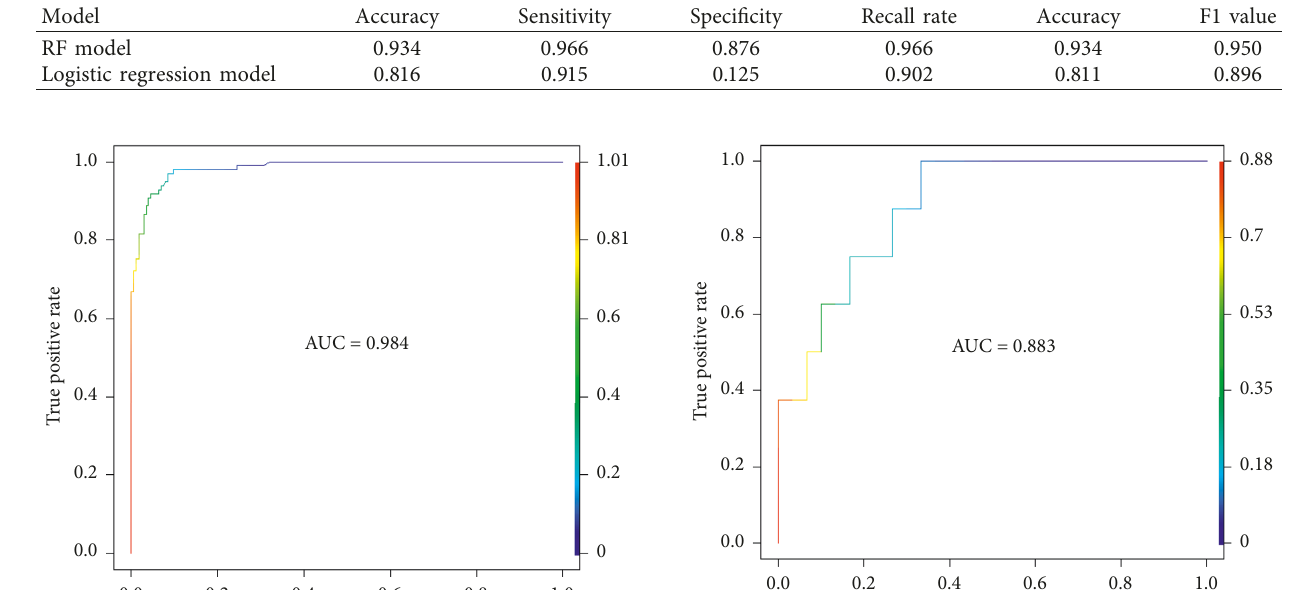
Figure 2: Order of importance of modeling Table 5: Comparison of prediction performance between the two models.